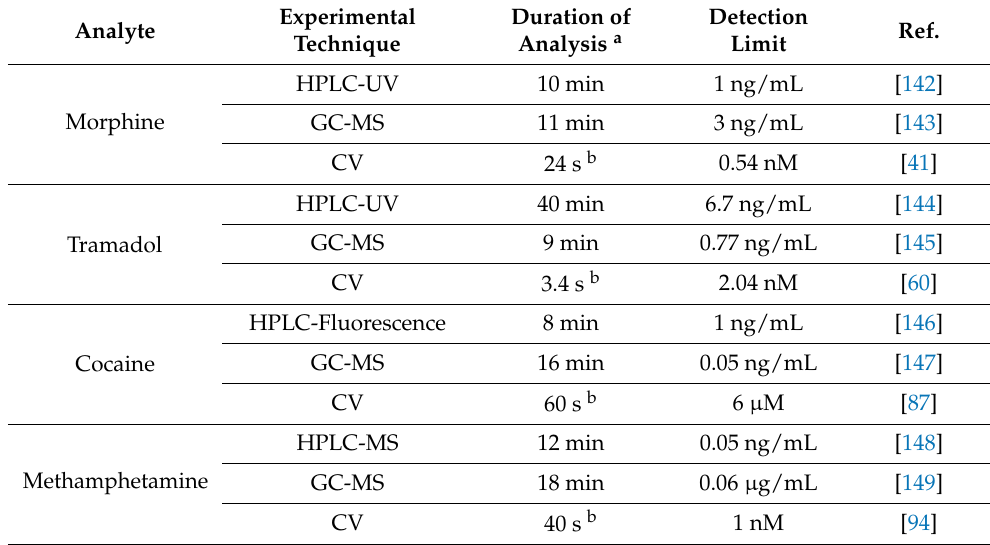
Table 4. Comparison of electrochemical sensors and chromatography techniques. Experimental Analyte Technique